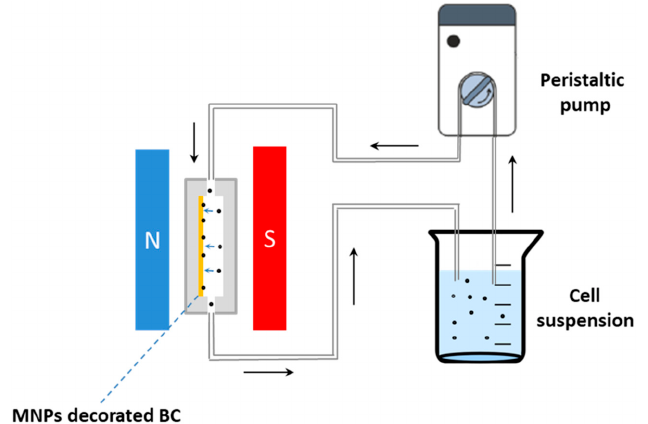
Figure 7. Schematic representation of the parallel-plate flow system used in [181]. Cells functionalized with MNPs were fluxed in the system under a magnetic field of 0.3 T and were magnetically attracted by the MNPs decorated bacterial cellulose (BC) hydrogel.